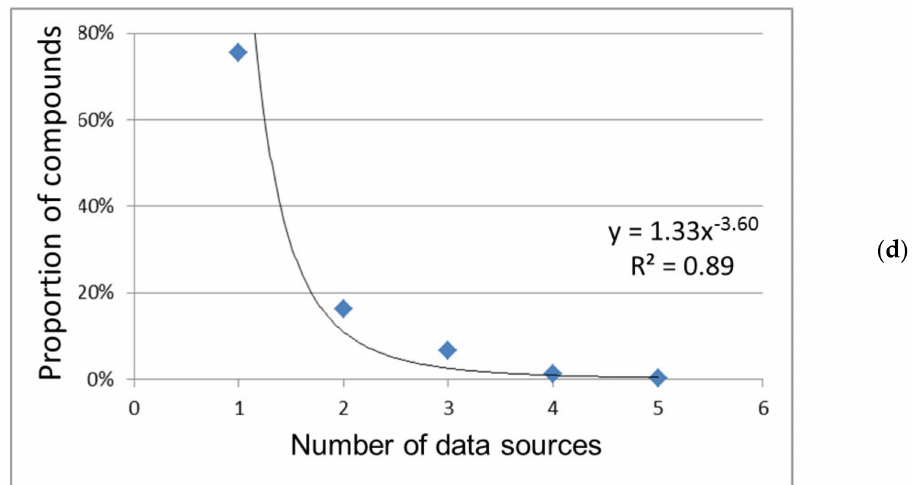
Figure 2. Distribution of compounds over different indicators in the PubChem database. ( a ) The size of records. Indicators are minimal (0) for (68.7 ± 0.4)% of compounds. ( b ) The number of vendors. Indicators are absent (0) for (59.1% ± 0.4%) of compounds. Very rare data for the most abundant compounds (from 14 to 75 vendors, total 0.1%) are not shown. ( c ) The number of patents. Indicators are absent (0) for (78.0% ± 0.4%) of compounds. Very rare data for the most abundant compounds (from 17 to 23036 patents, total 0.3%) are not shown. ( d ) The number of sources. Indicators are minimal (1, the database itself) for (75.4 ± 0.4)% of compounds. Very rare data for most abundant compounds (from 6 to 20 sources, total 0.3%) are not